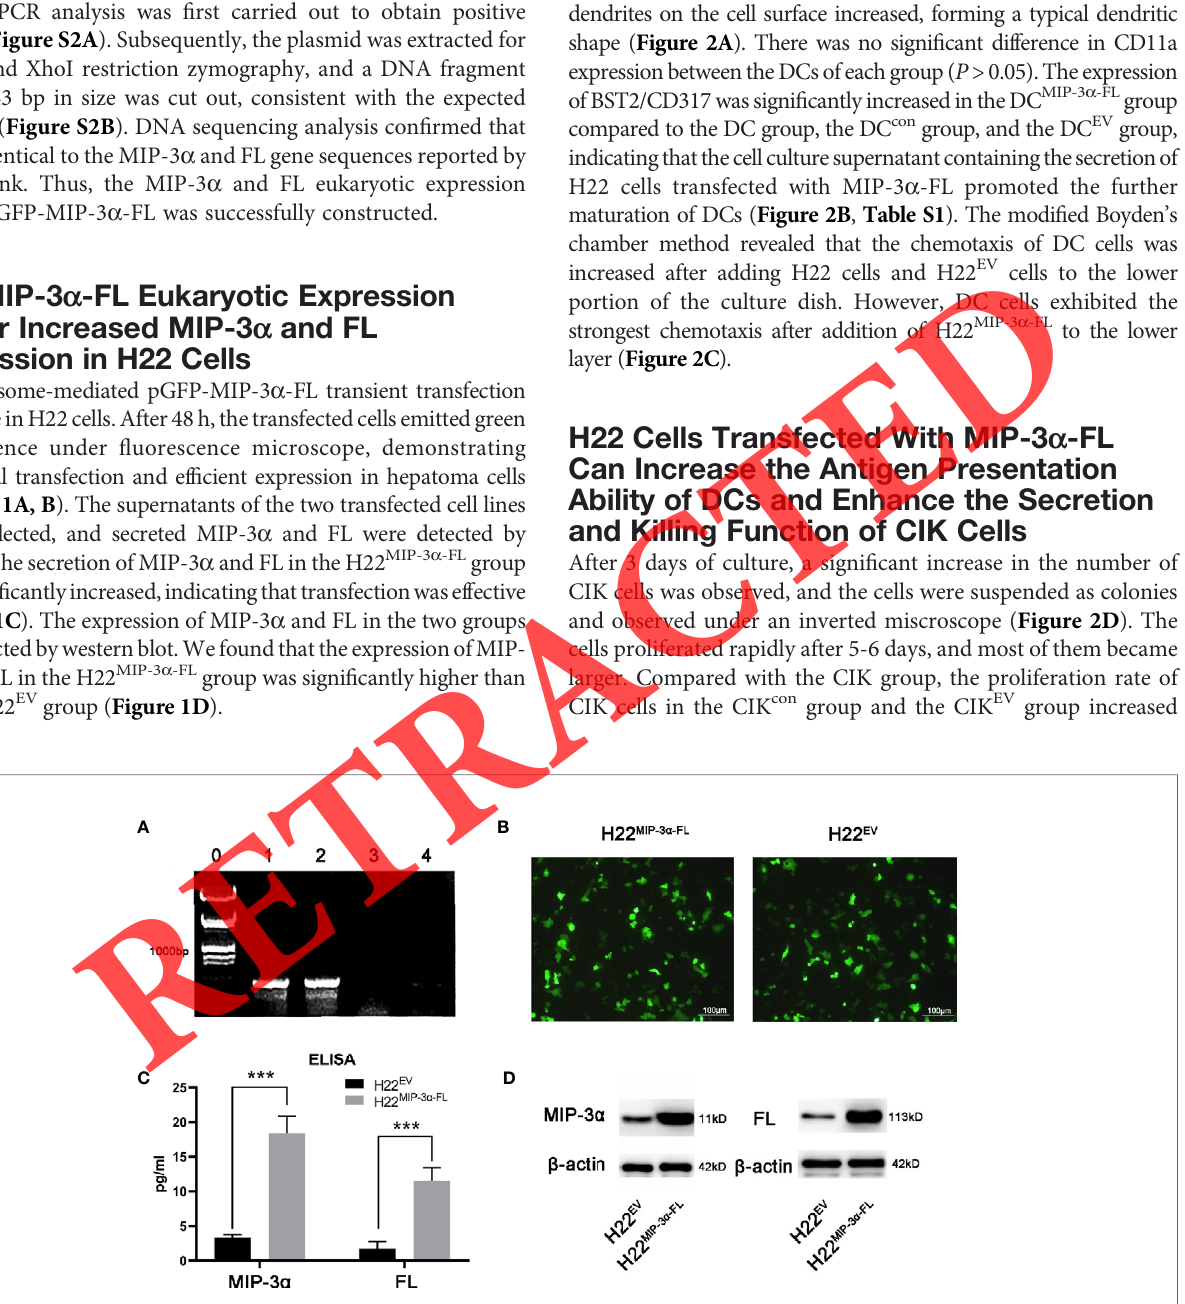
FIGURE 1 | MIP-3 a -FL eukaryotic expression vector was introduced into H22 cells, increasing the expression and secretion of MIP-3 a and FL. (A) The expression of the pGFP-MIP-3 a -FL gene in H22 cells detected by RT-PCR before and after transfection (Lane 0: marker, lane 1: positive control, lane 2: H22 after transfection of recombinant plasmid, lane 3: H22 before transfection, and lane 4: negative control). (B) Scanning image of H22 EV and H22 MIP-3 a -FL under a laser confocal microscope after transfection for 48 h (light focusing microscope, magni fi cation ×100). (C) Detection of MIP-3 a and FL secretion by ELISA. *** P <0.001. (D) The images of protein in H22 EV and H22 MIP-3 a -FL as determined by western